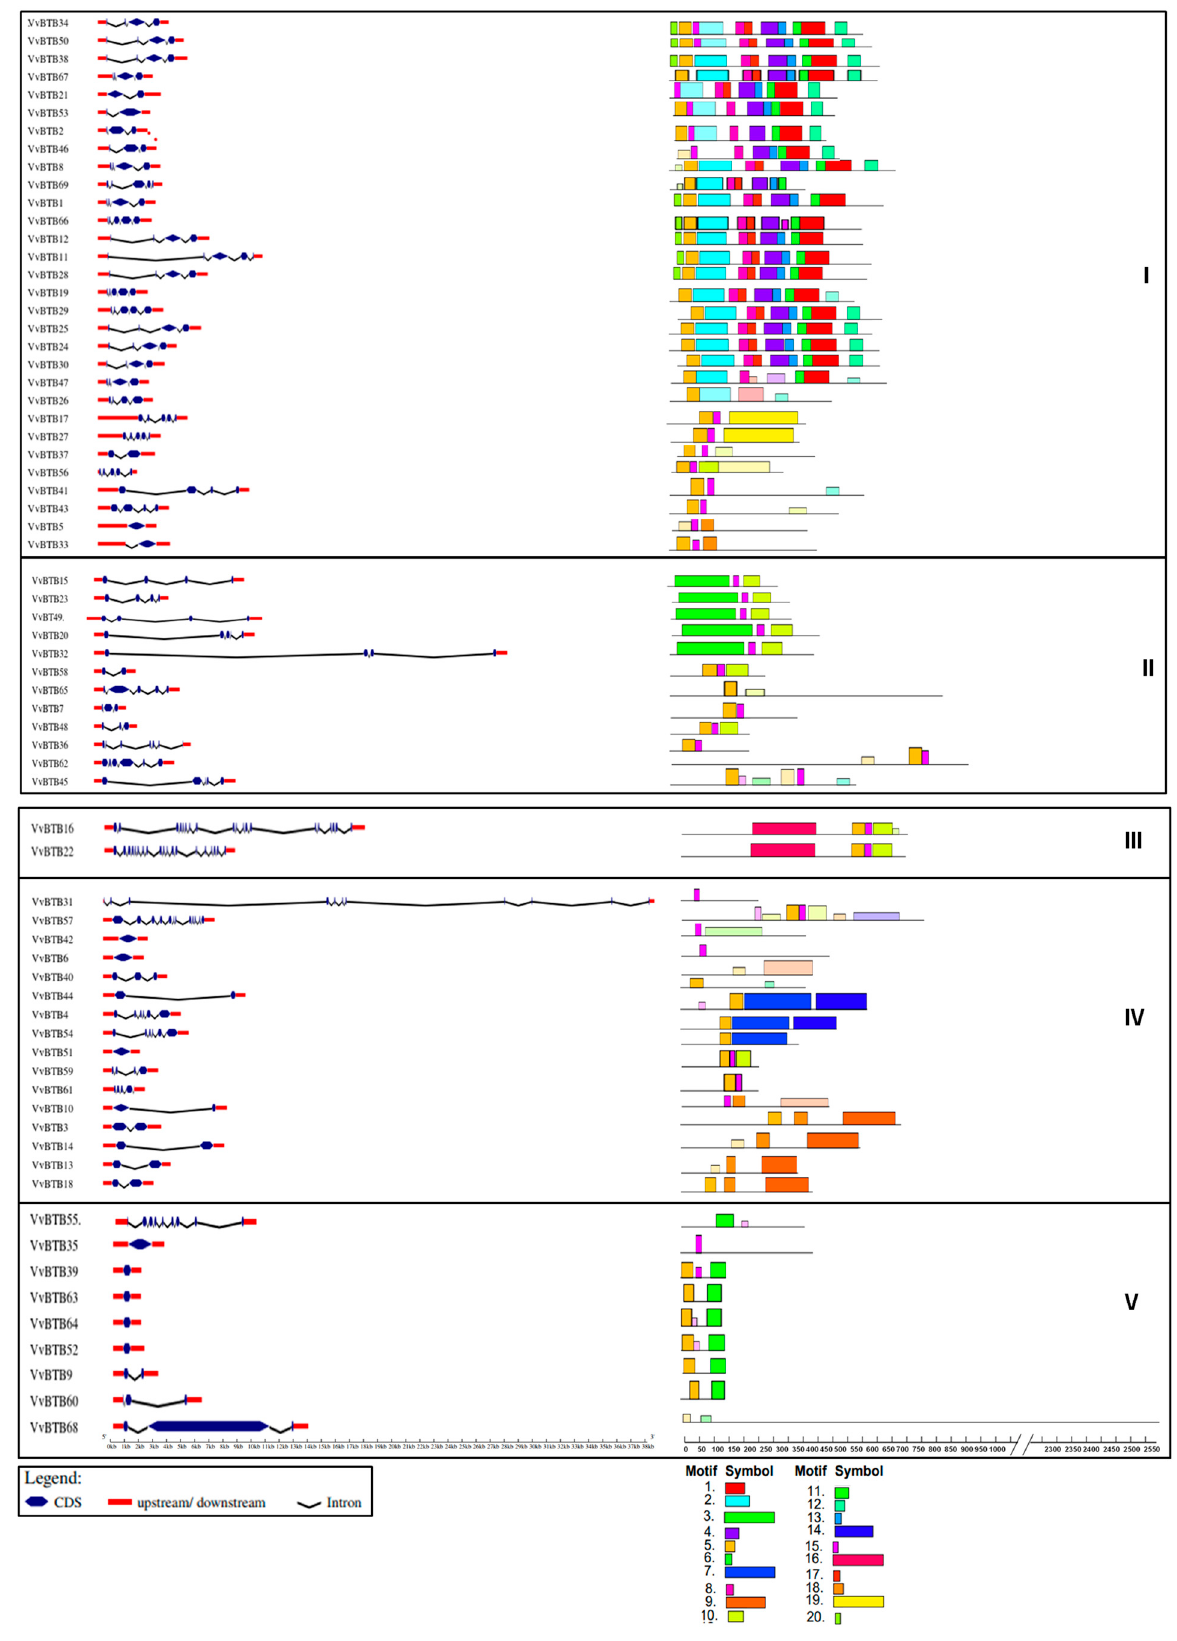
Figure 3. Groupwise intron–exon organizations and motif analysis. Conserved motif analysis using MEME and 20 different motifs are depicted by different-colored boxes.